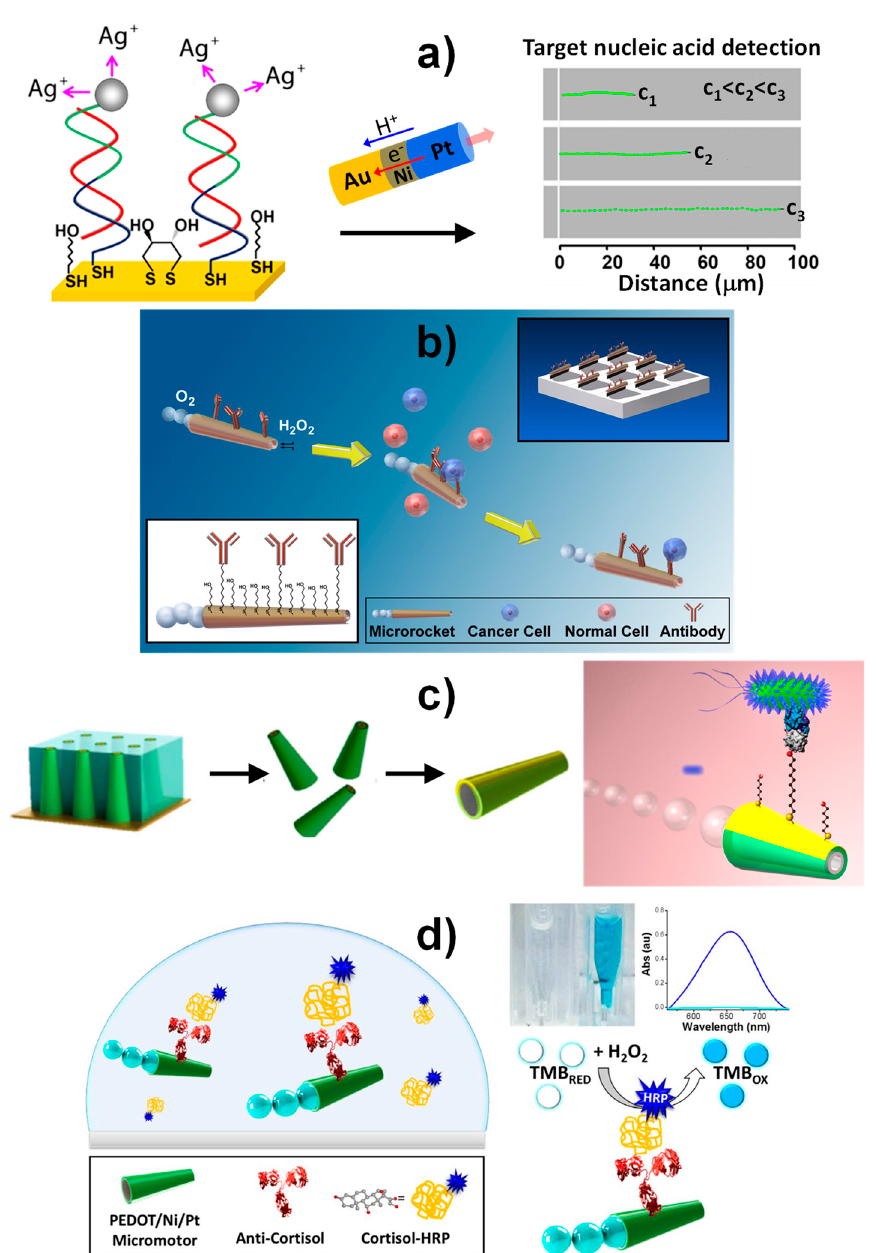
Figure 11. Optical biosensing using catalytic magnetic Janus motors ( a ) and tubular motors prepared by top-down photolithography ( b ) or template electrodeposition ( c , d ). Detection of: Nucleic acids with catalytic Au-Ni-Pt nanowires ( a ), cancer cells with Ti/Ni/Au/Pt microtubes modified with antibodies ( b ) bacteria with lectin-modified Au/Ni/PANI/Pt microtubular engines ( c ) and naked-eye detection of cortisol with antibodies-functionalized Au/PEDOT/Ni/Pt microtubes ( d ). Reprinted and adapted from Reference [75] ( a ), Reference [78] ( b ), Reference [79] ( c ) and Reference [84] ( d ) with permission.